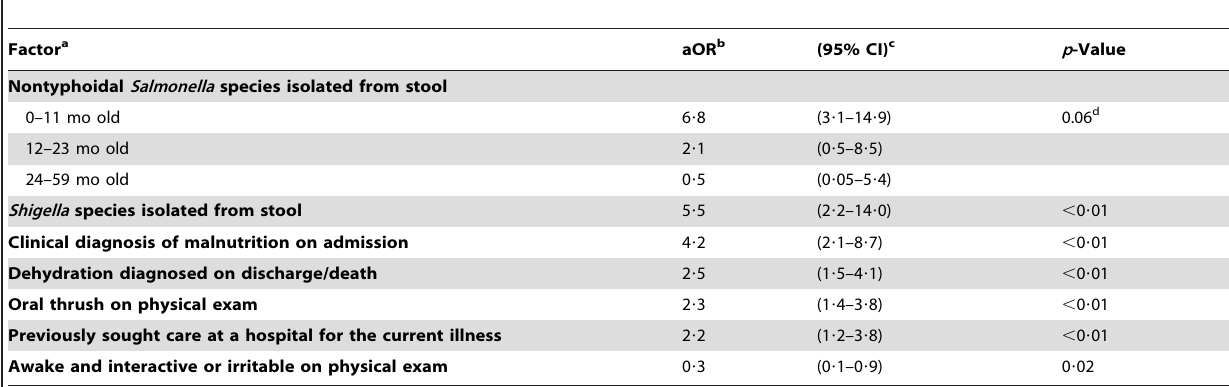
Table 5. Factors independently associated with an increased or decreased risk of death among children , 5 y old hospitalized with diarrhea in a multivariable logistic regression analysis, western Kenya